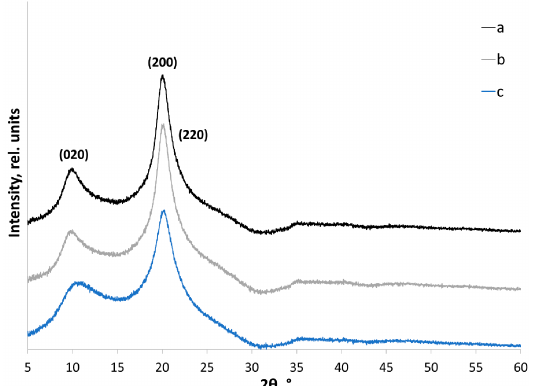
Figure 3. X-ray powder diffraction patterns of initial chitosan: (a) high MW; (b) medium MW; and (c) low MW. The curves are shifted for clarity as indicated.